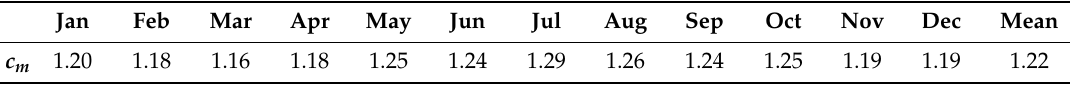
Table 2. Monthly erosivity conversion factors c m (unitless) for 30 min timestep compared to the base timestep of five